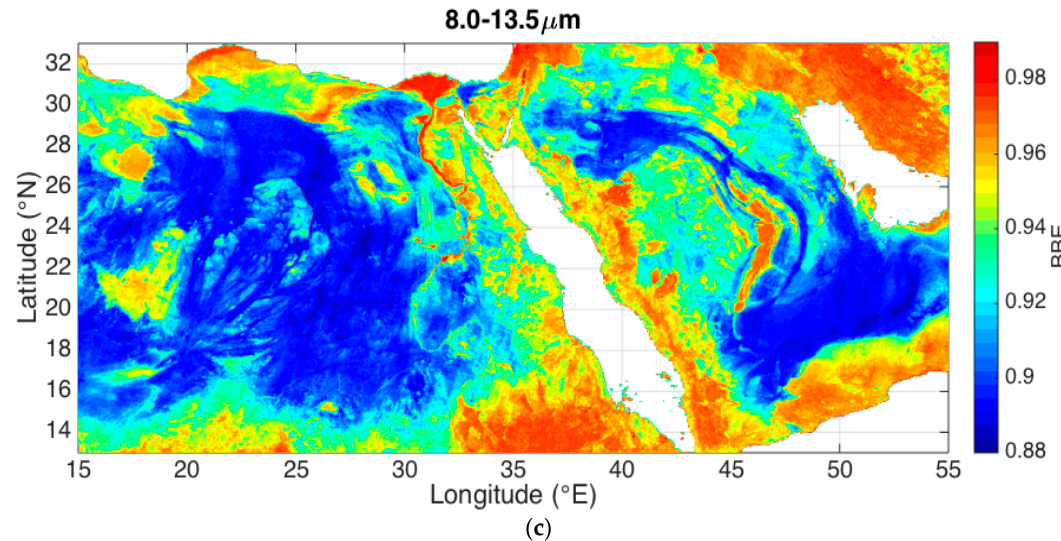
Figure 4. January 2007 CAMEL BBE for ( a ) 3.6–14.3 µm and; ( b ) 8.0–13.5 µm with ( c ) cutout over the eastern Sahara Desert and Arabian Peninsula for the 8.0–13.5 µm BBE.